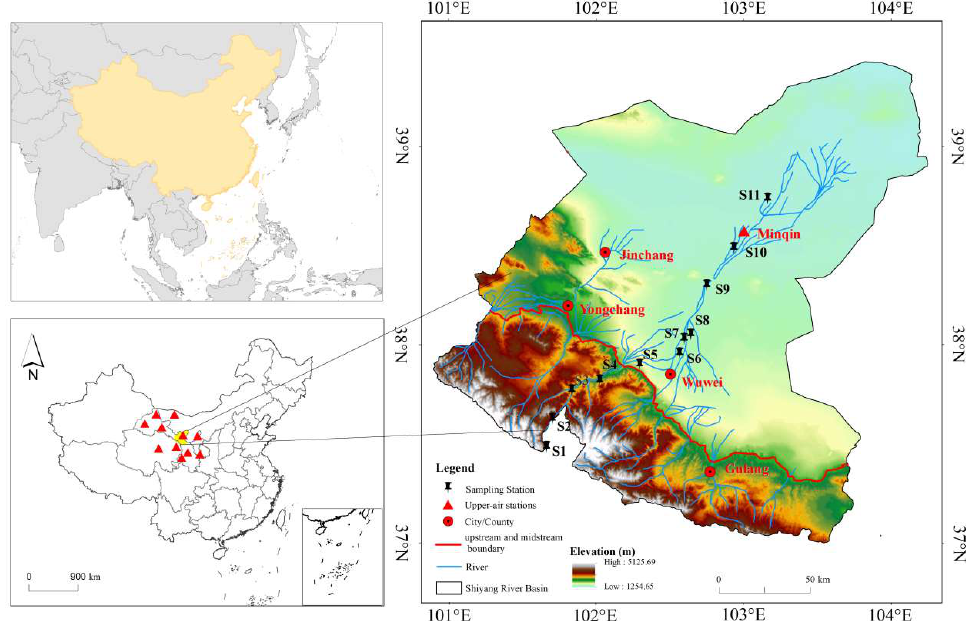
Figure 1. Map showing the locations of sampling sites in the Shiyang River Basin, According to the topographical characteristics and the hydrological characteristics of each section of the Shiyang River Basin, it is divided into three sections, which are labeled as upstream: Lenglongling (S1), Hulinzhan (S2), Hujianxiang (S3), Xiyingwugou (S4), midstream: Xiyingzhen (S5), Yangxiaba (S6), Dengjiazhuang (S7), Jiuduntan (S8), and downstream: Xuebaizhen (S9) Hongqigu (S10), Datanxiang